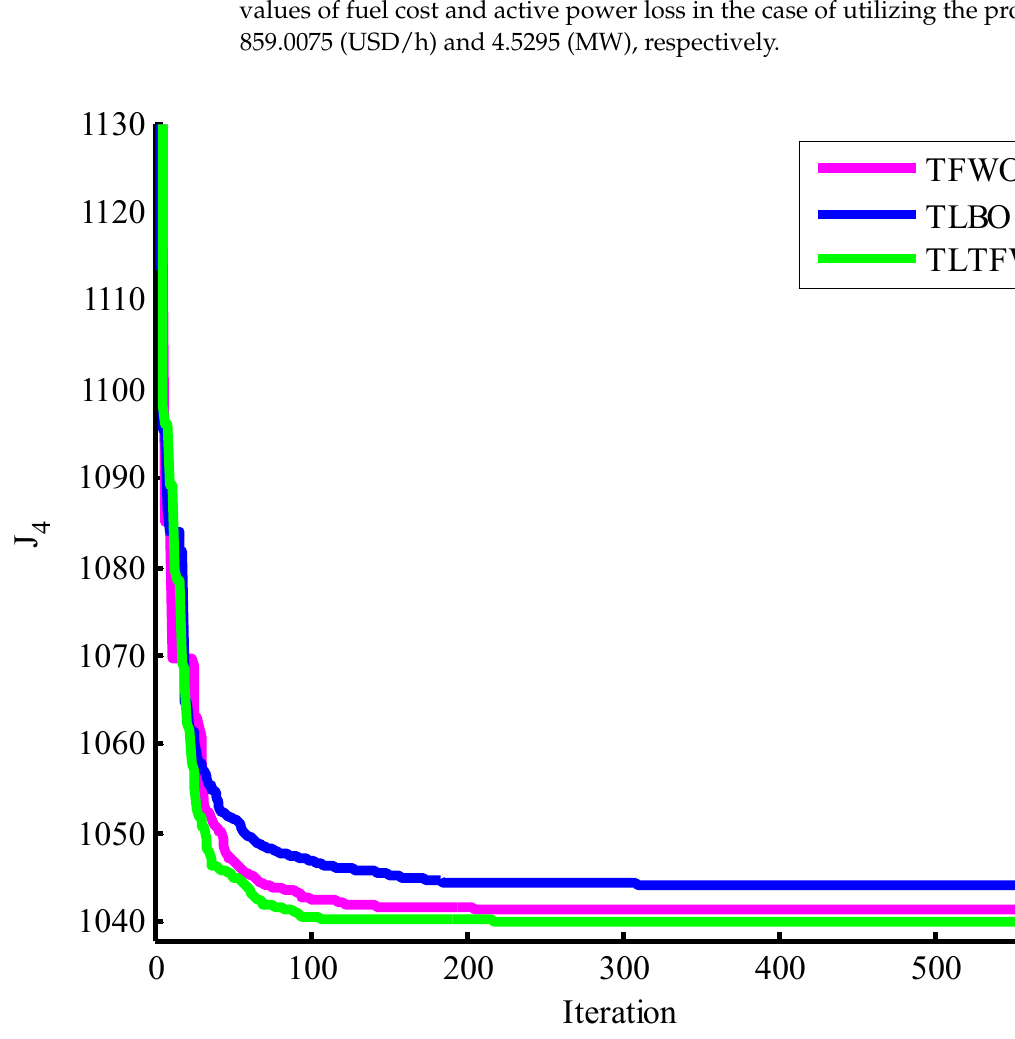
Figure 8. Convergence trends for Case 4.